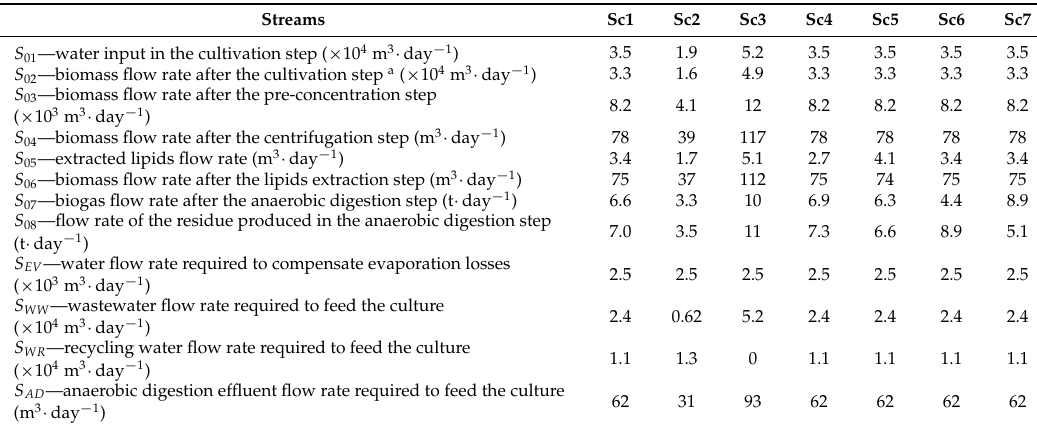
Table 2. Mass balance to the flow streams involved in the process determined in each of the studied scenarios